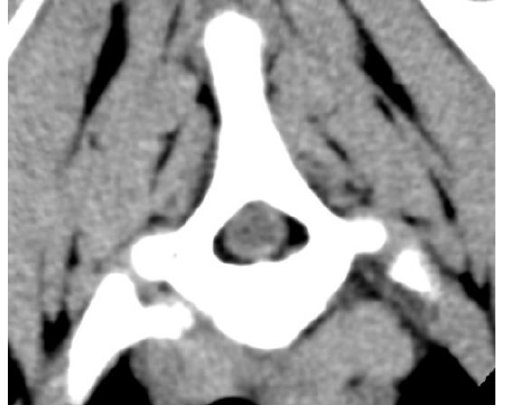
Figure 1. Transverse precontrast CT image at the level of C3 – C4, showing intradural, extraparenchymal hyperattenuating changes. Reconstructed with soft tissue algorithm, window width (WW) 150, window level (WL) 35.